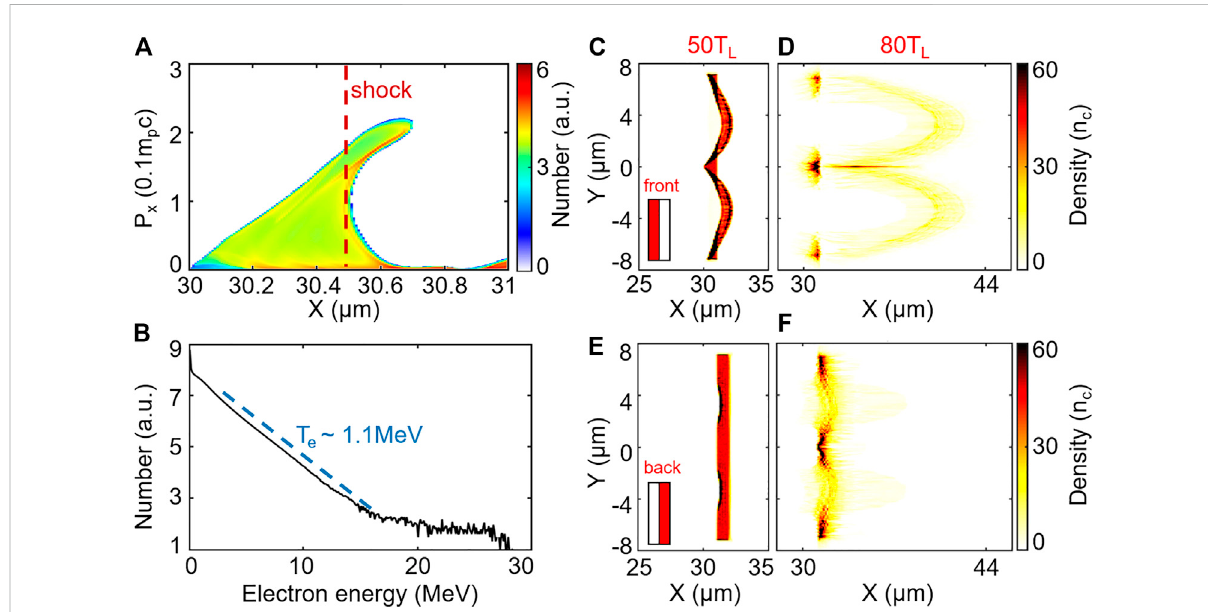
FIGURE 3 Protonaccelerationinshockaccelerationstage. (A) Protonphasespaceat t =50 T L .Thereddashedlinerepresentstheshockfront. (B) Electron energyspectrumandelectrontemperatureat t =50 T L .Distributionof (C,D) theprotonsinthefrontofthetargetat t =50 T L ,80 T L .Distributionof (E,F) the protons in the back of the target at t = 50 T L , 80 T L .